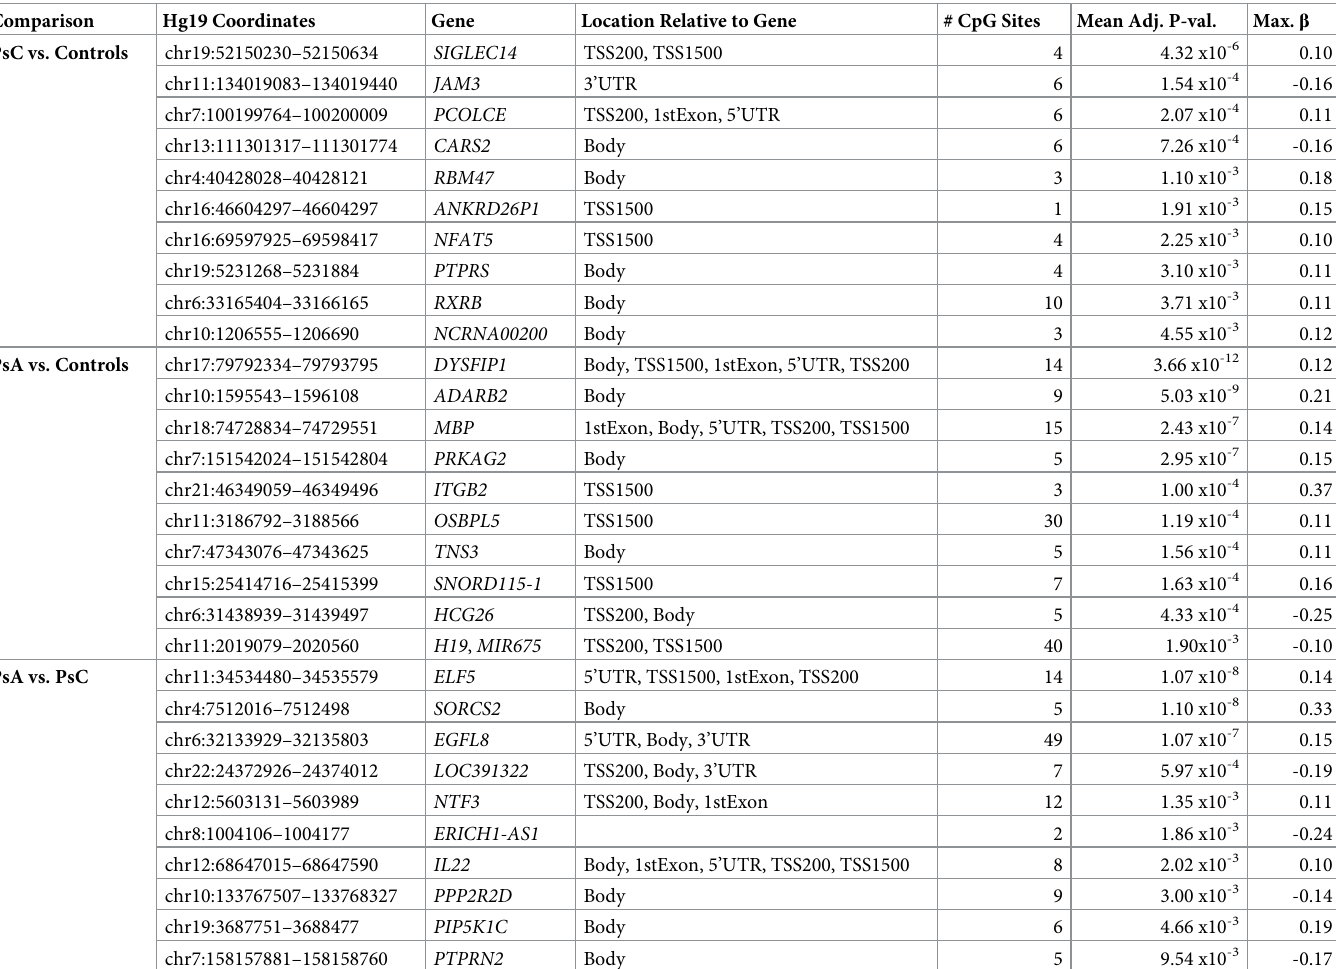
Table 2. Biologically relevant DMRs with � 10% change in methylation identified in each of the 3 comparisons.